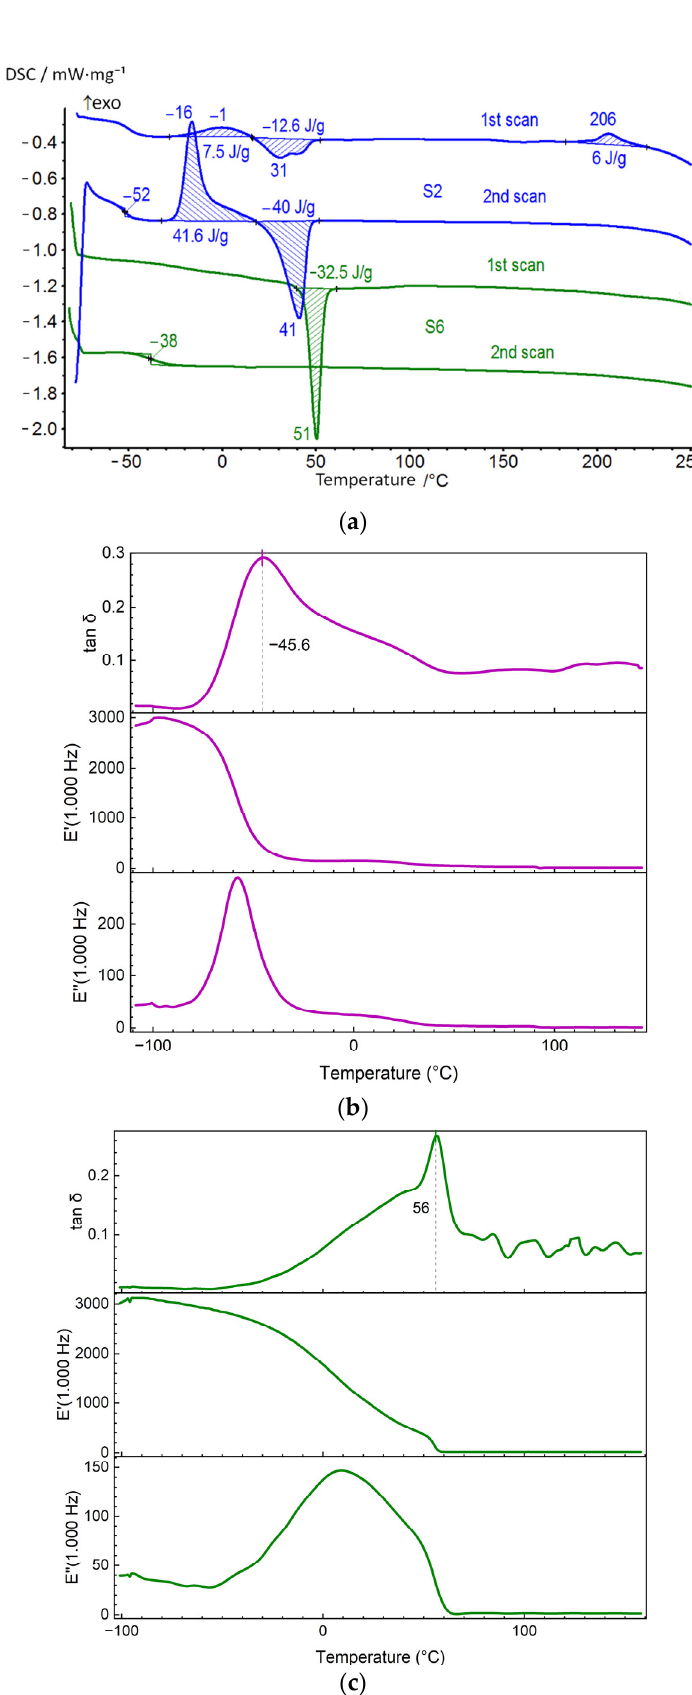
Figure 7. DSC curves ( a ) of segmented PUU for the compositions S2 and S6 and DMA ( b , c ), respec ‐ tively.